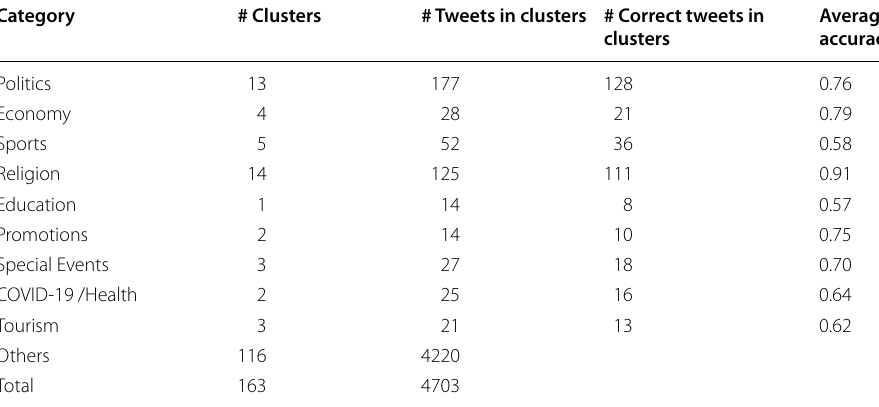
Table 3 Evaluation results of the unsupervised learning approach